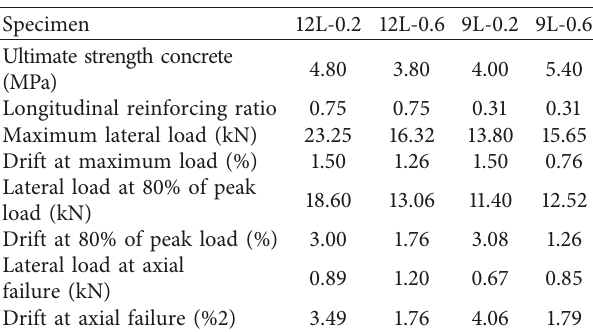
Table 3: Summaries of the column specimens test results.